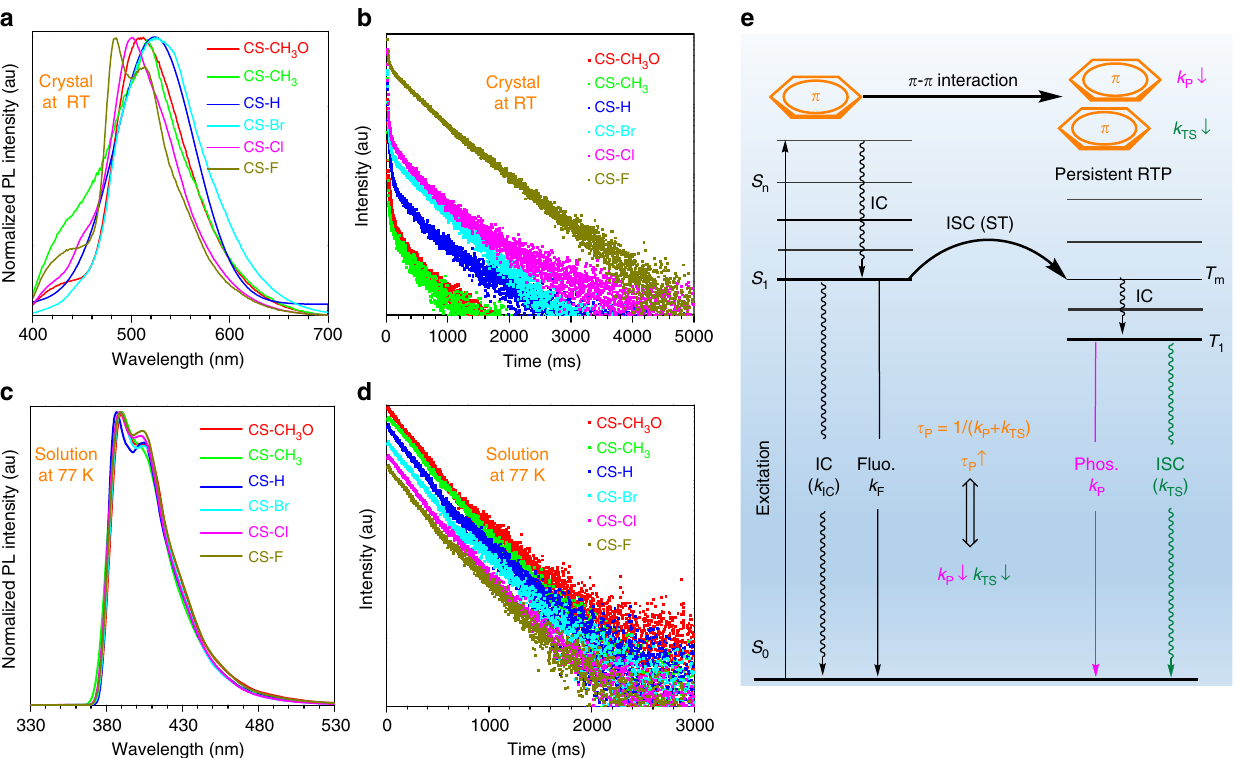
Fig. 2 The phosphorescence spectra and corresponding time-resolved decay curves for the six compounds. a The normalized room temperature phosphorescence spectra of CS-CH 3 O, CS-CH 3 , CS-H, CS-Br, CS-Cl, and CS-F in crystal state. b Time-resolved PL-decay curves for their room temperature phosphorescence in crystal state. c The normalized low temperature (77 K) phosphorescence spectra in dichloromethane solution, concentration: 10 − 5 M. d Time-resolved PL-decay curves for their low temperature phosphorescence in dichloromethane solution, concentration: 10 − 5 M. e The proposed mechanism for organic persistent RTP: the strong π – π interaction could decrease the radiative transition ( k P ) and non-radiative transition ( k TS ) from T 1 to S 0 state, thus achieving the persistent room temperature